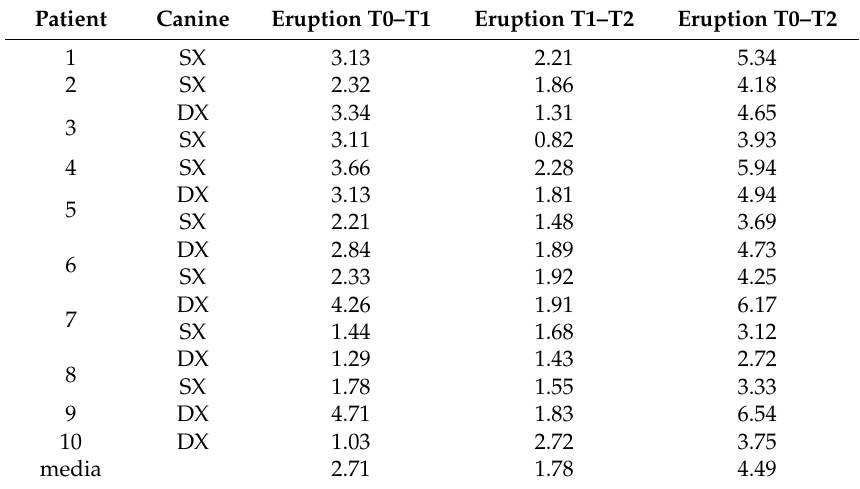
Table 8. Eruption values: distance in mm between the cusp of canine in the CT (T0) and the cusp at 2 (T1) ant 4 months